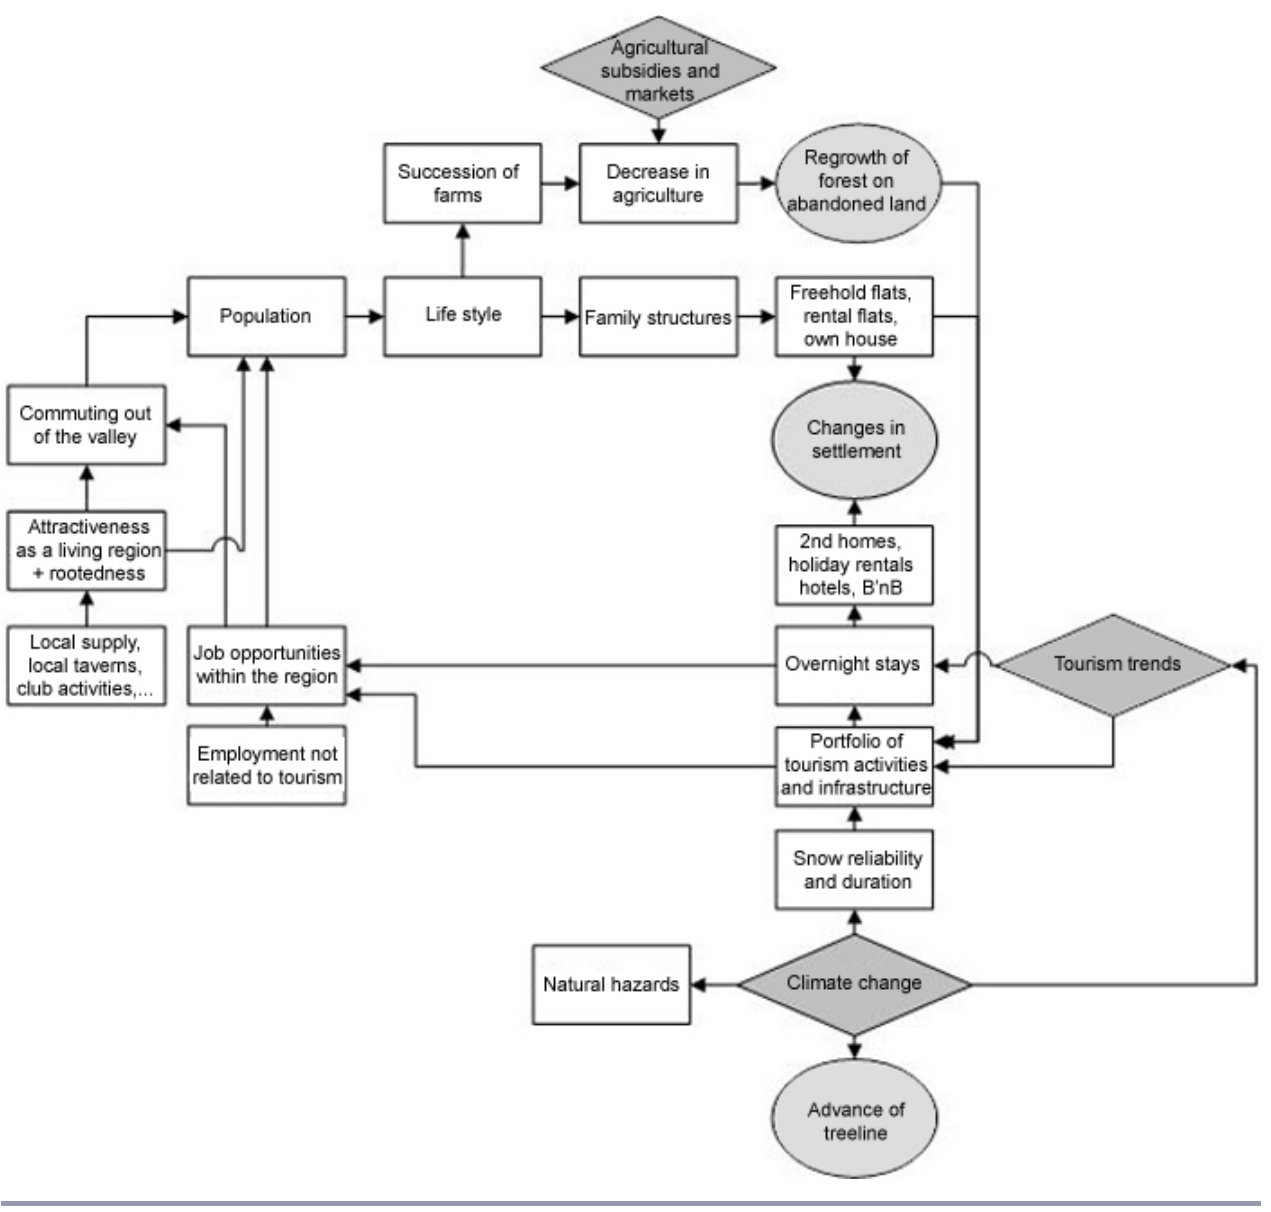
Fig. 2 . Cause-effect relations summary diagram focusing on relationships releasing landscape transition. General driving forces affecting society and landscape are indicated with diamonds. Rectangles show the system elements (actors and related pressures) releasing responsive behaviour. Ellipses show general impacts on landscape